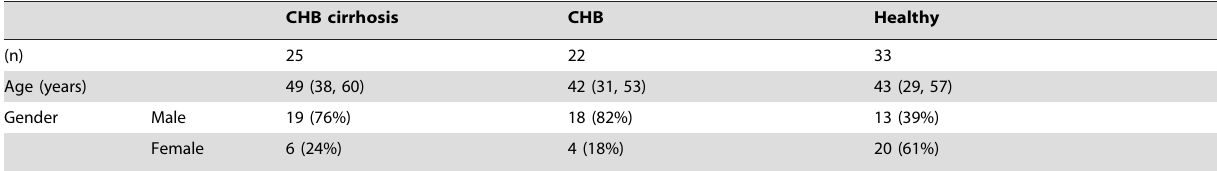
Table 1. Characteristics of the whole